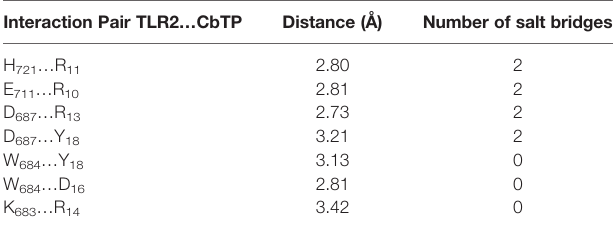
TABLE 4 | The distance and salt bridges of the binding residues between CbTP and